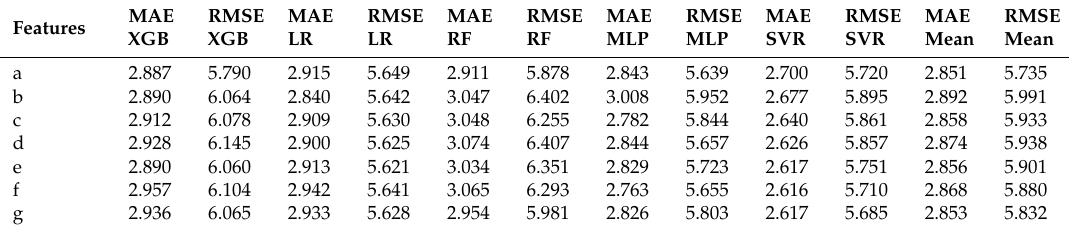
Table 1. RMSE and MAE for the same-pixel features from previous months, using seven different configurations and five different machine-learning techniques.